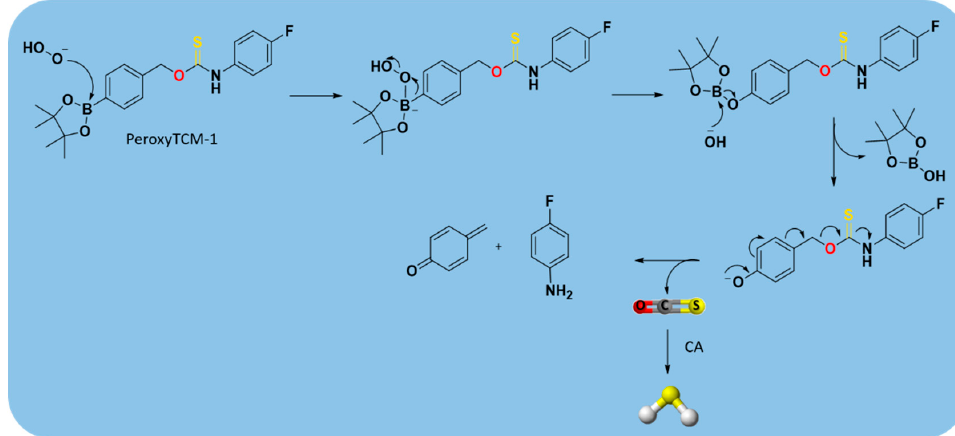
Figure 15. Proposed mechanism for H 2 O 2 -triggered COS/H 2 S release.